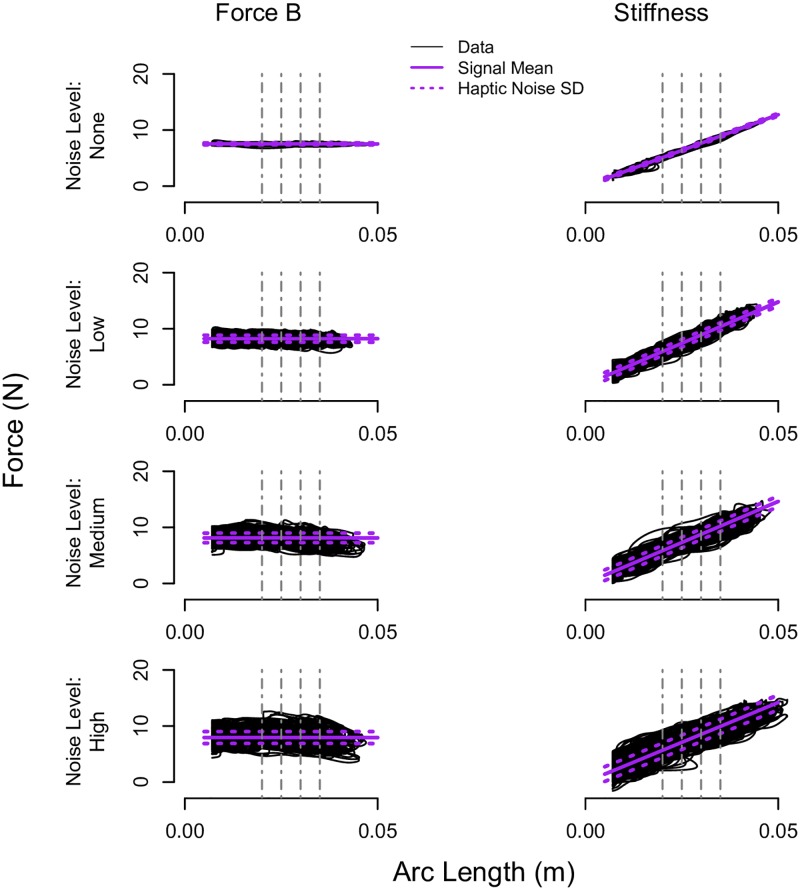
Representative participant data.Force versus arc length data for a representative participant when pressing on the standard Force B and Stiffness signals across each noise level (None, Low, Medium, and High). The smoothed and thresholded finger arc length data are indicated by the black solid lines, and the mean stimulus and the mean stimulus plus and minus the standard deviation of the haptic noise (Haptic Noise SD) are displayed by the purple solid and dotted lines, respectively. The commanded penetration arc lengths of P = 0.02, 0.025, 0.03, and 0.035 m are indicated by the vertical dashed and dotted gray lines.